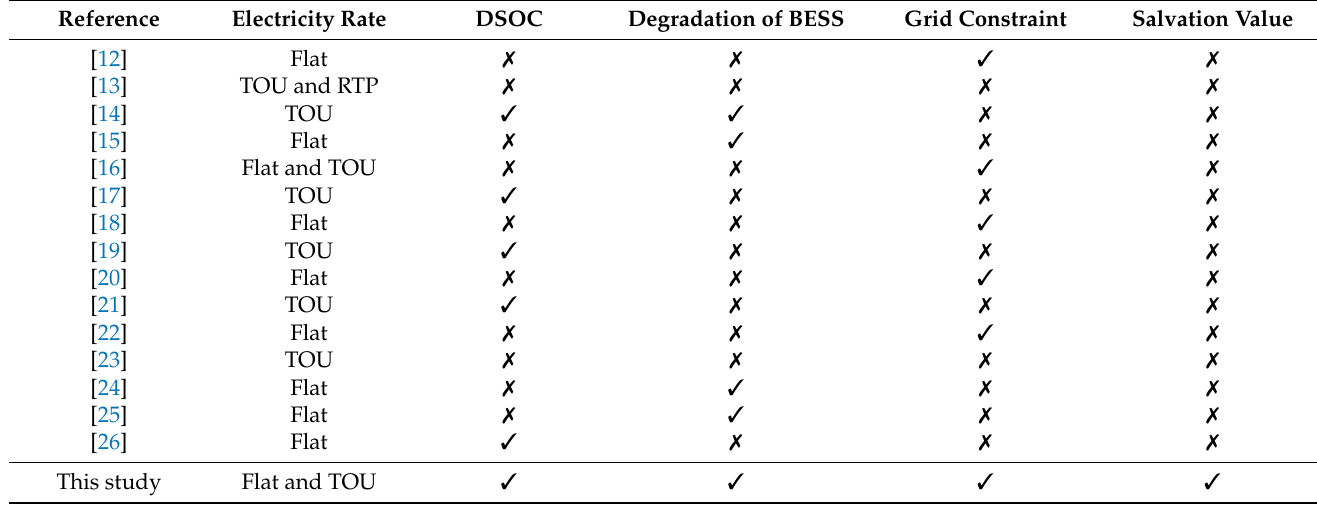
Table 1. Summary of limitations of existing studies on optimal sizing of PV and BESS for GCHs. Reference Electricity Rate Degradation of BESS Grid